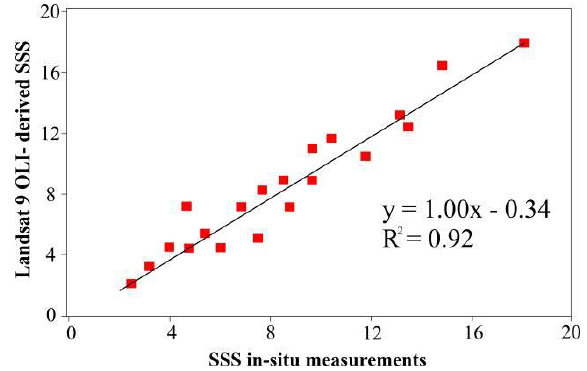
Table 2 . In-situ SSS values (ppt) of Caspian Sea (August 2022, post monsoon period).